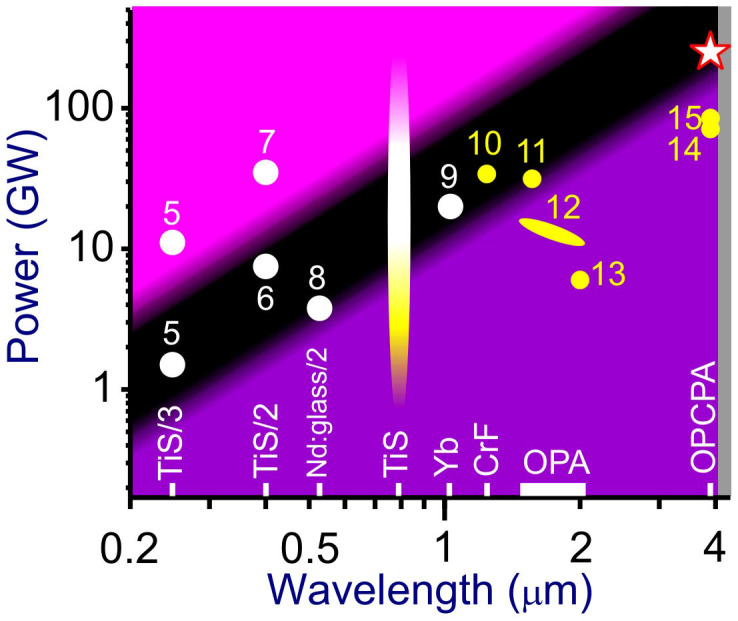
Survey of filamentation experiments in gas media12356789101112131415.The peak power of laser pulses used for laser-induced filamentation is shown versus the central wavelength of these pulses for experiments performed in the atmospheric air (white circles) and in high-pressure gases (yellow circles): high-pressure N210, Ar at a pressure of 5 bar11, Kr at 4 bar12, Xe at 2.1 bar13, Ar at 4.5 bar14, O2 and N2 at 4.5 bar15. References are given by numbers. Single-filamentation regime in the atmospheric air exists in the dark area of the diagram. Its loosely defined boundaries are shown by gradient shading, with the lower boundary centered at the critical power of self-focusing, Pcr = C(8πn0n2)−1λ2, C ≈ 6.4, and the upper boundary centered at 7Pcr. Above the upper boundary, a laser beam tends to break up into multiple filaments. Continuum of filamentation experiments using Ti: sapphire (TiS) laser systems123 is shown by the ellipse centered at 800 nm. Other sources of ultrashort pulses for filamentation experiments (shown along the abscissa axis) include Yb: CaF2 laser (Yb), Cr: forsterite laser (CrF), optical parametric amplifier (OPA), optical parametric chirped-pulse amplifier (OPCPA), the second harmonic of a Nd: glass laser (Nd: glass/2), and the second (TiS/2) and third (TiS/3) harmonics of a Ti: sapphire laser output. Filamentation experiments presented in this work are shown by a star. The grey area on the right represents the atmospheric CO2 absorption band.